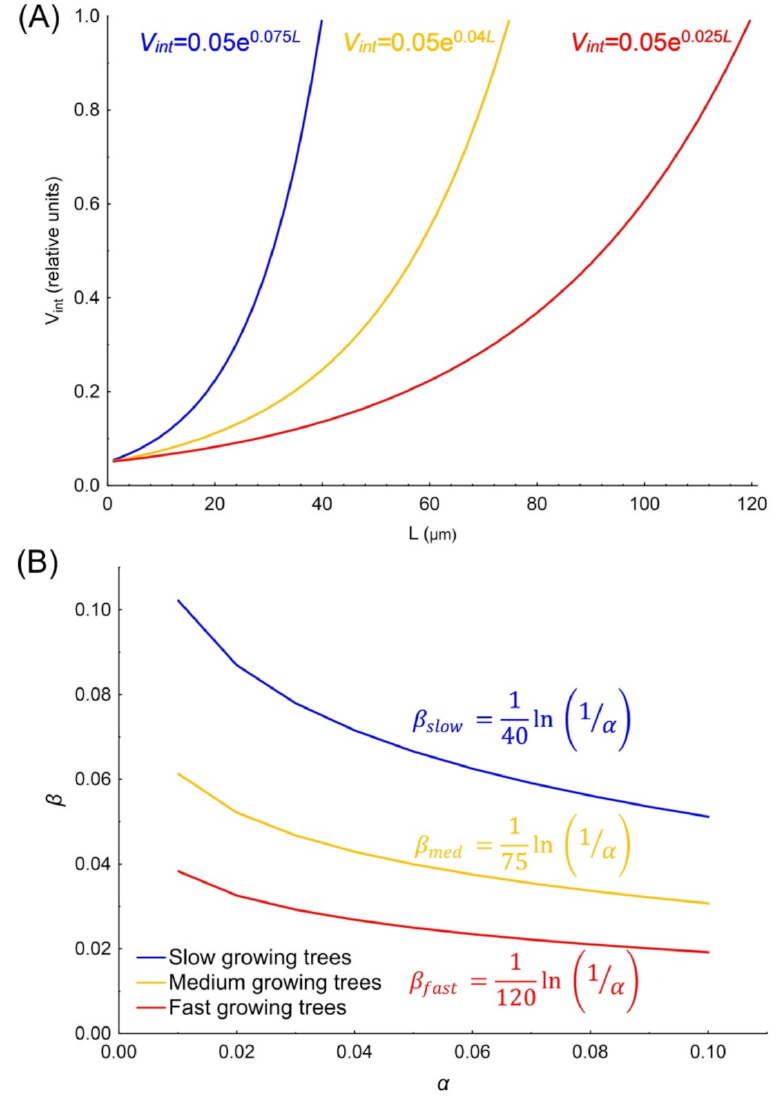
Figure 4. Dependence of the rate V int on the length of the cambial zone L for slow- ( β = 0.075; blue curve), medium- ( β = 0.040; yellow curve), and fast-growing- ( β = 0.025; red curve) annual rings at the same α = 0.05 in optimal growing conditions (i.e., V ext = V int = 1) ( A ); Dependence of β on α for slow- (blue curve), medium- (yellow curve) and fast-growing- (red curve) trees in optimal growing conditions ( B ). All equations used are indicated in corresponded colors. Table 2. Estimated values of the increment ∆ L of the cambial tape per time unit for different values of the external growth rate V ext , obtained for a slow-, medium- and fast-growing synthetic trees. ∆ L ( µ